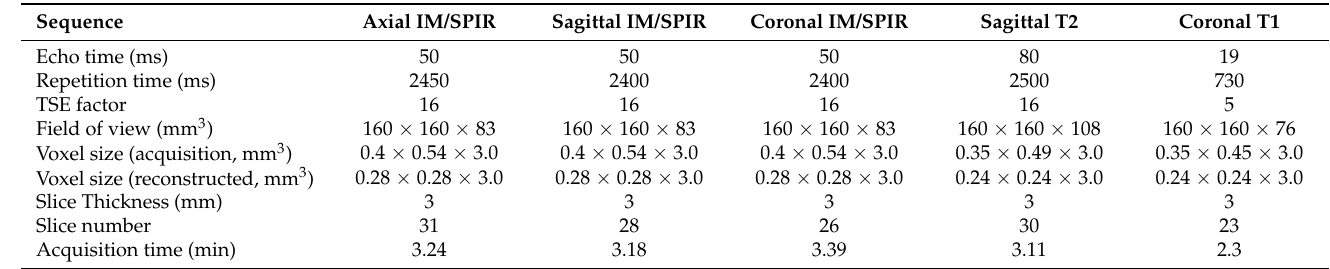
Table 1. Sequence parameters of the sequences used in this study (Ingenia, Elition,